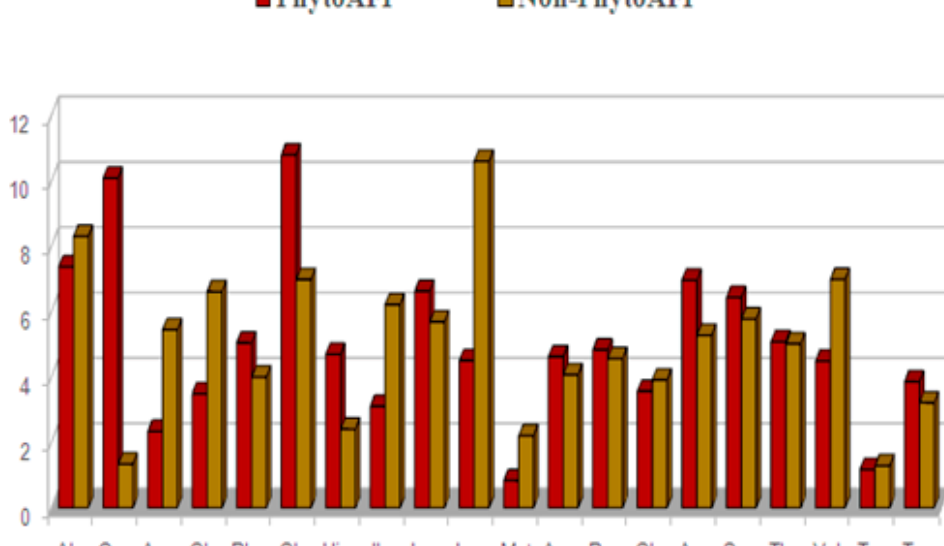
Figure 3. Amino acid composition of PhytoAFP and Non ‐ PhytoAFP.